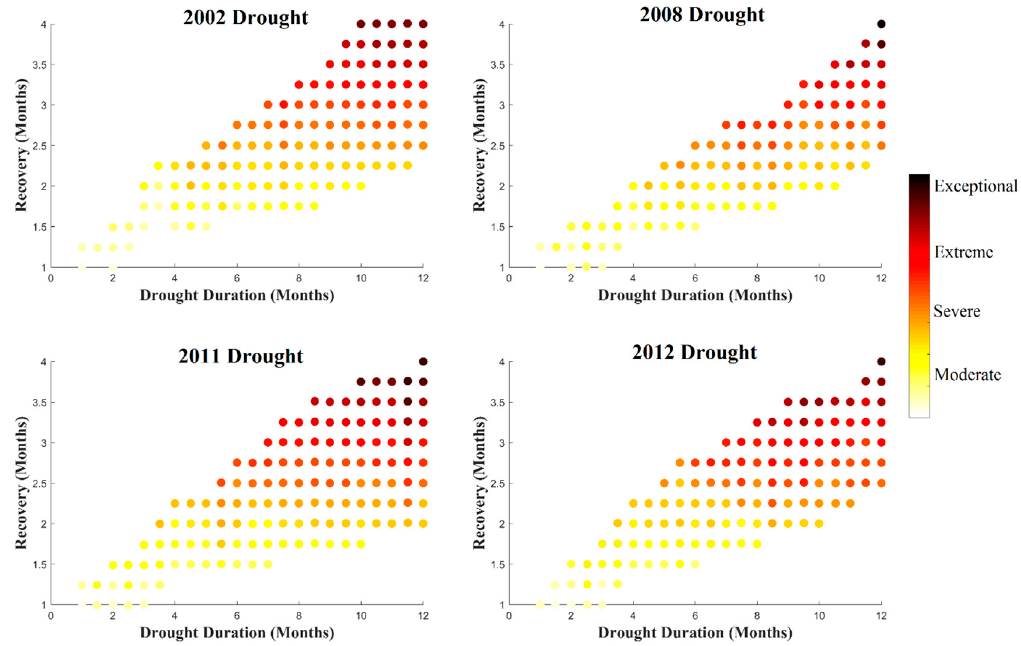
Figure 6. The relation between drought recovery time ( y -axis), drought duration ( x -axis) and drought intensity (color bar) for the 2002, 2008, 2011 and 2012 drought episodes.